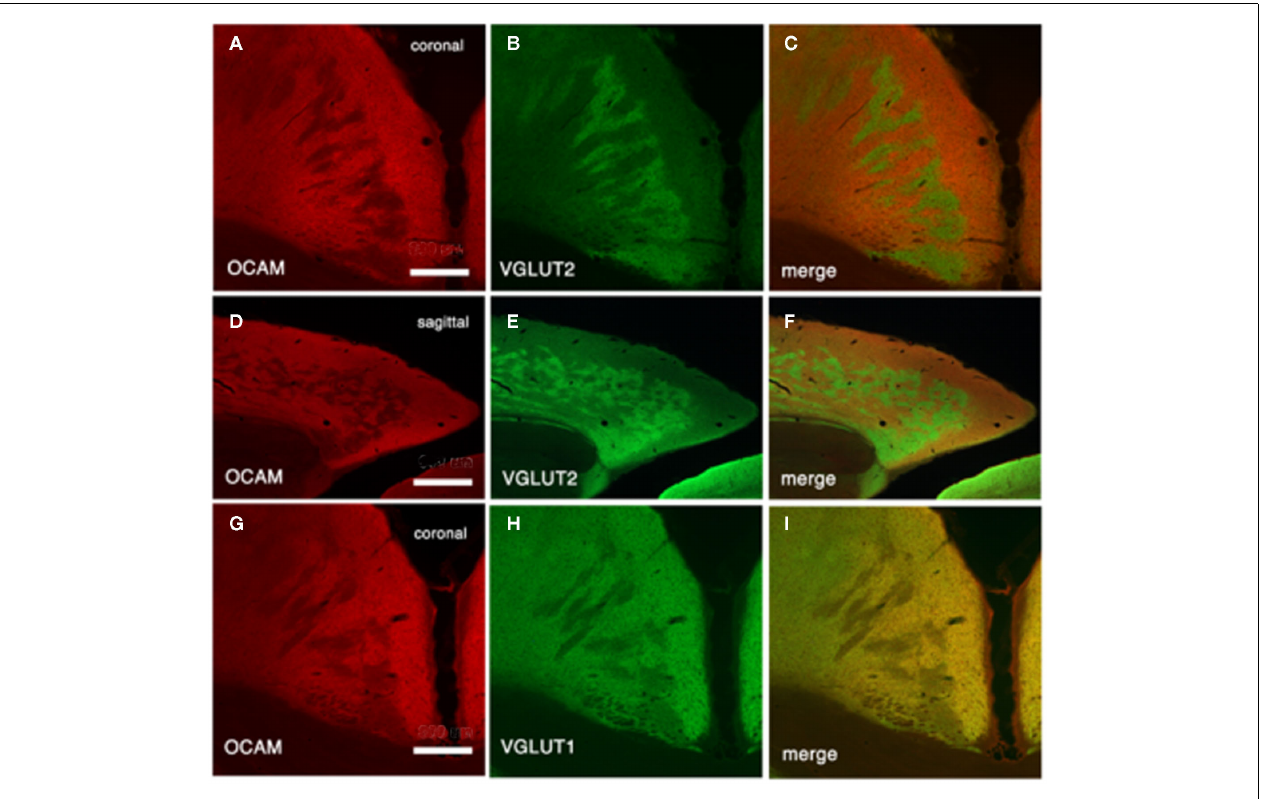
FIGURE 6 |Architectonics of mutant GRS, visualized by immunohistochemistry for OCAM andVGLUT2 (presumptive thalamocortical terminations) orVGLUT1 (presumptive